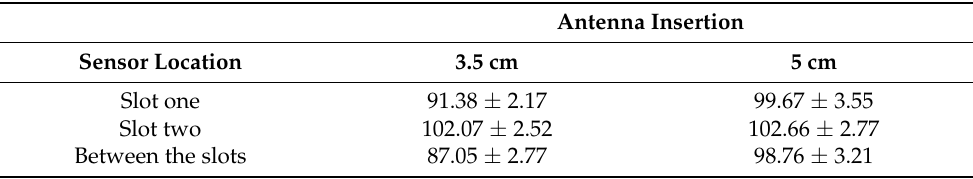
Figure 5. Temperature profiles generated by the double slot antenna located at different antenna insertions. ( a ) Temperature profiles recorded next to slot 1 of the antenna, ( b ) temperature profiles recorded at the middle point between the slots, ( c ) temperature profiles recorded next to slot 2 of the antenna. The red line represents the temperature recorded for an antenna insertion of 3.5 cm, while the blue line describes the temperature recorded for an antenna insertion of 5 cm. Table 3. Maximum temperature elevations reached by the double slot antenna at different levels of antenna insertion.